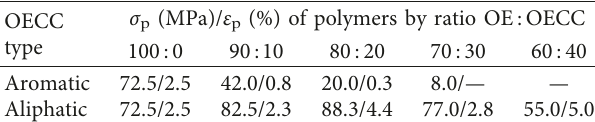
Table 6: Mechanical properties of polymers based on epoxy compositions modified by OECC and cured